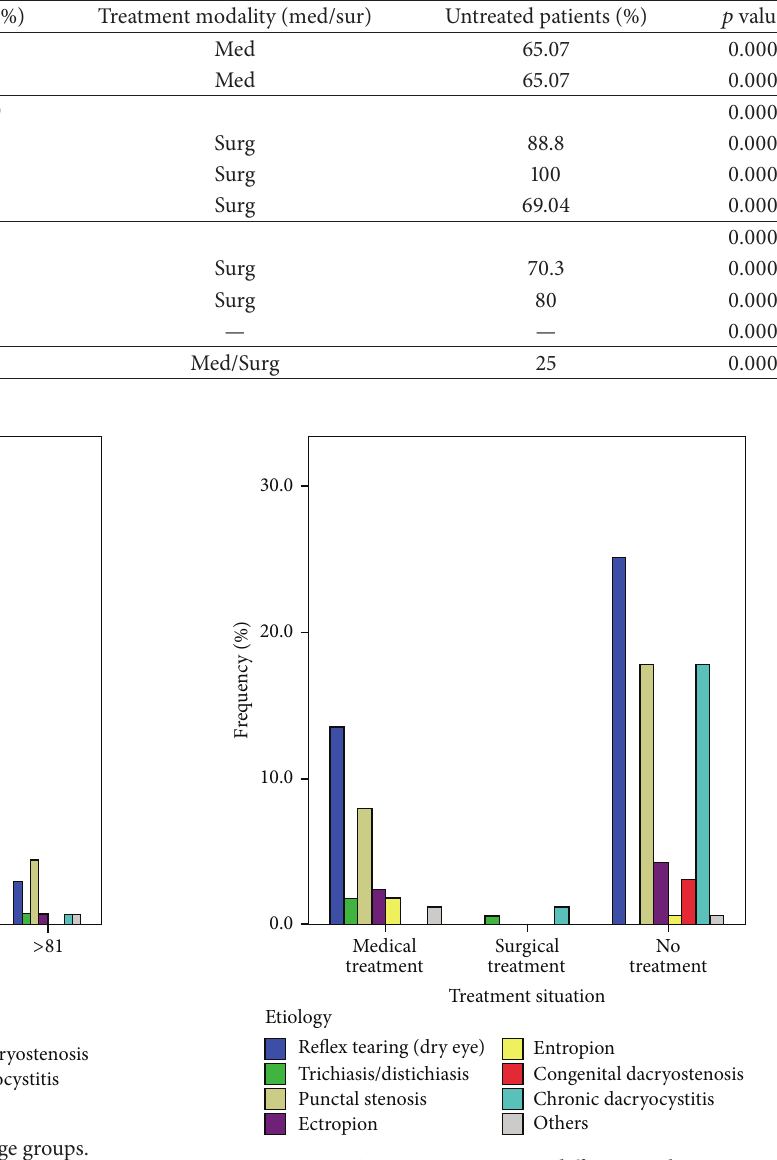
Figure 2: Treatment situation in different